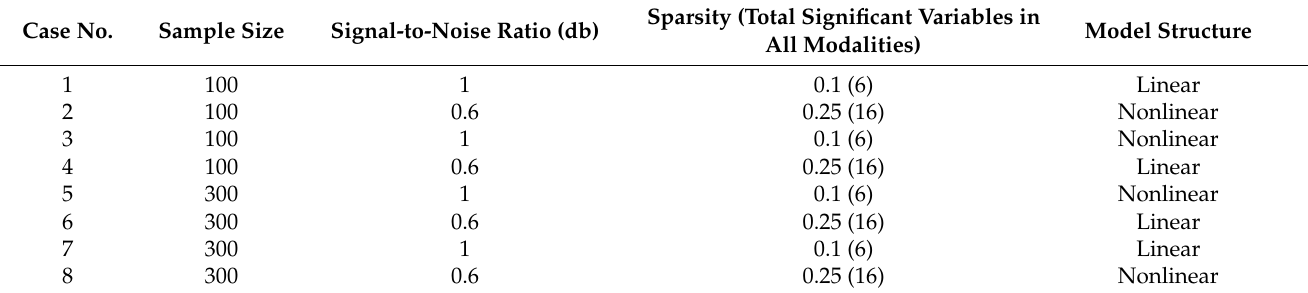
Table 1. Simulation